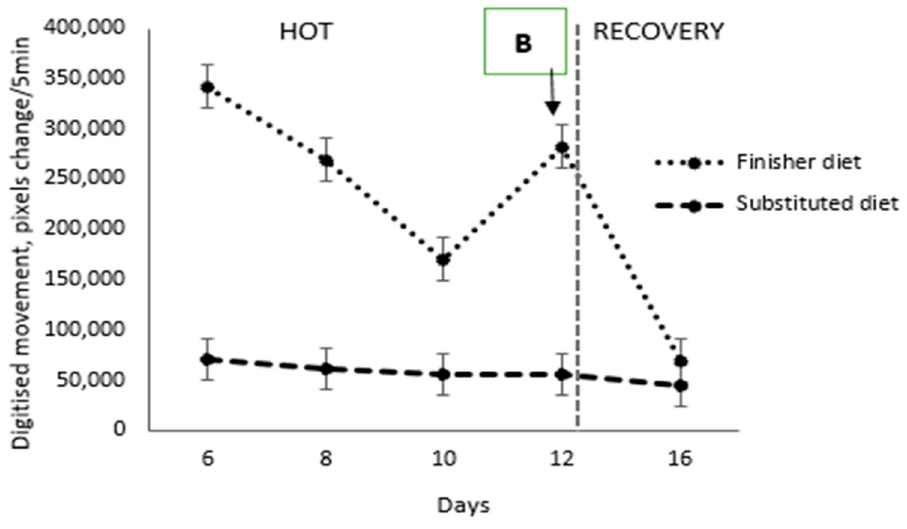
Figure 1. The daily video-digitised movement (pixel changes/5 min) in finisher and substituted diet